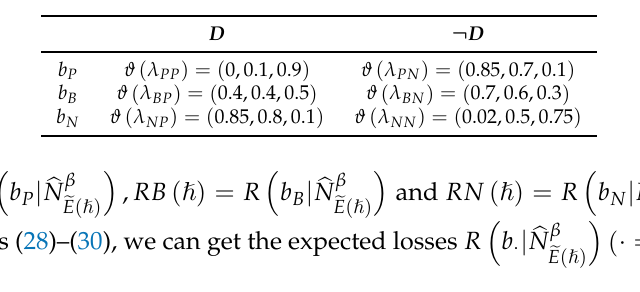
Table 6. The loss function 1 matrix in this Example.